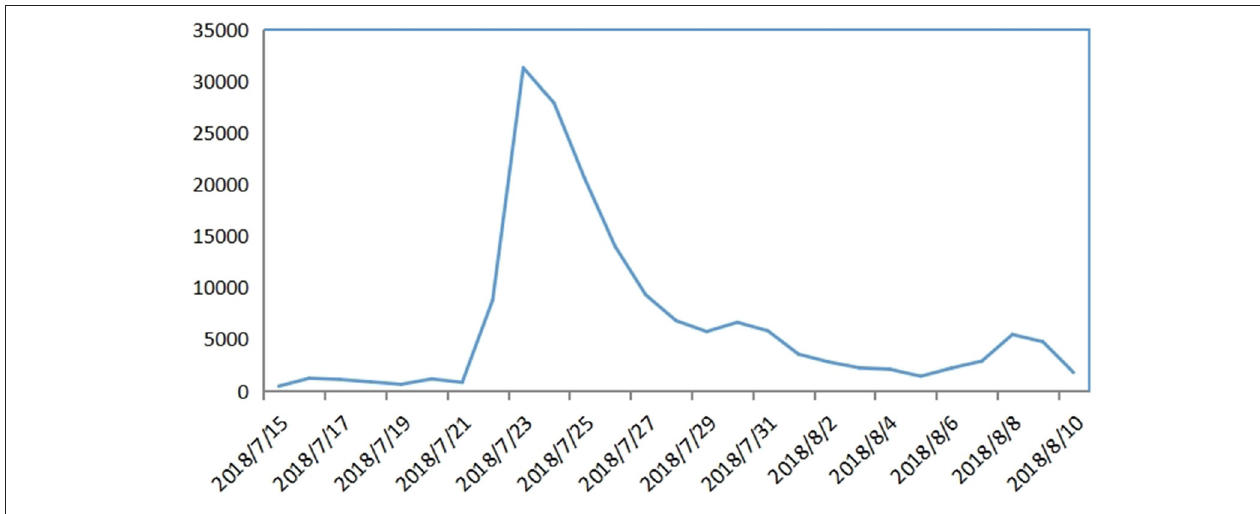
FIGURE 3 | Changchun Longevity Biotechnology Co., Ltd. vaccine fraud incident: Internet public opinion development trend (source: ZhiWeiData). The vertical axis represents the number of pieces of information; the horizontal axis represents the date.